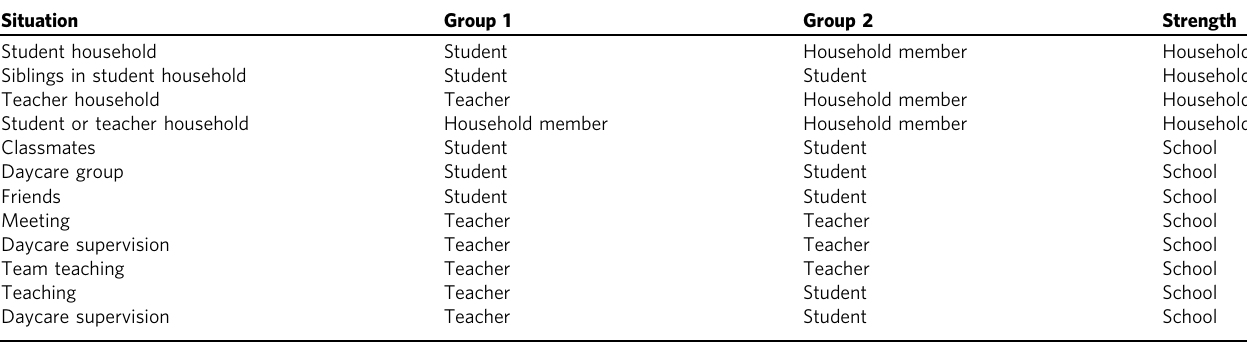
Table 3 Contacts that arise from different situations in the school context between different agent